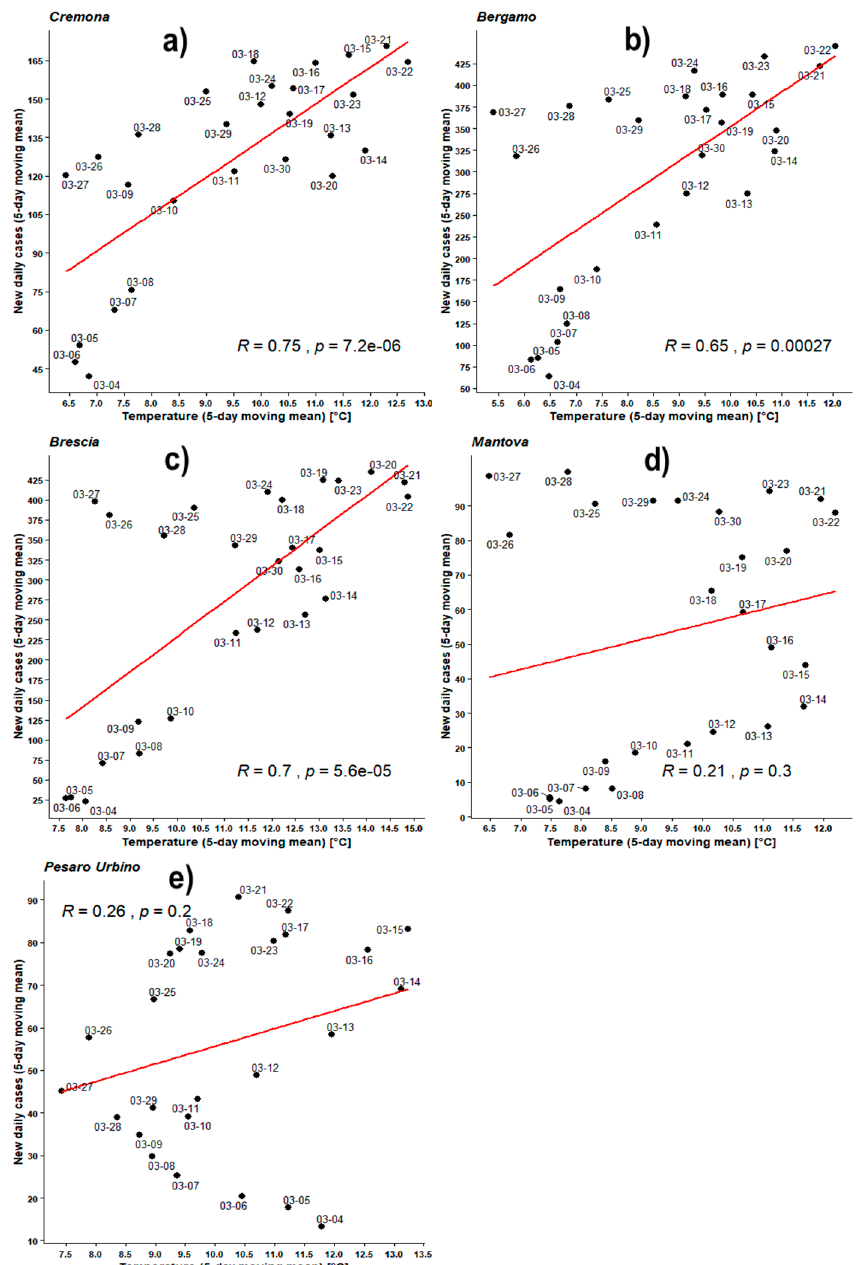
Figure 4. Scatter plot and linear regression for the 5-day moving means of new daily cases of COVID-19 against outdoor temperatures for five Italian provinces: ( a ) Cremona, ( b ) Bergamo, ( c ) Brescia, ( d ) Mantova, ( e ) Pesaro Urbino. Labels report, in MM-DD format, the last day of the moving means. Pearson correlation coe ffi cient is reported as ‘R’ while probability value is reported as